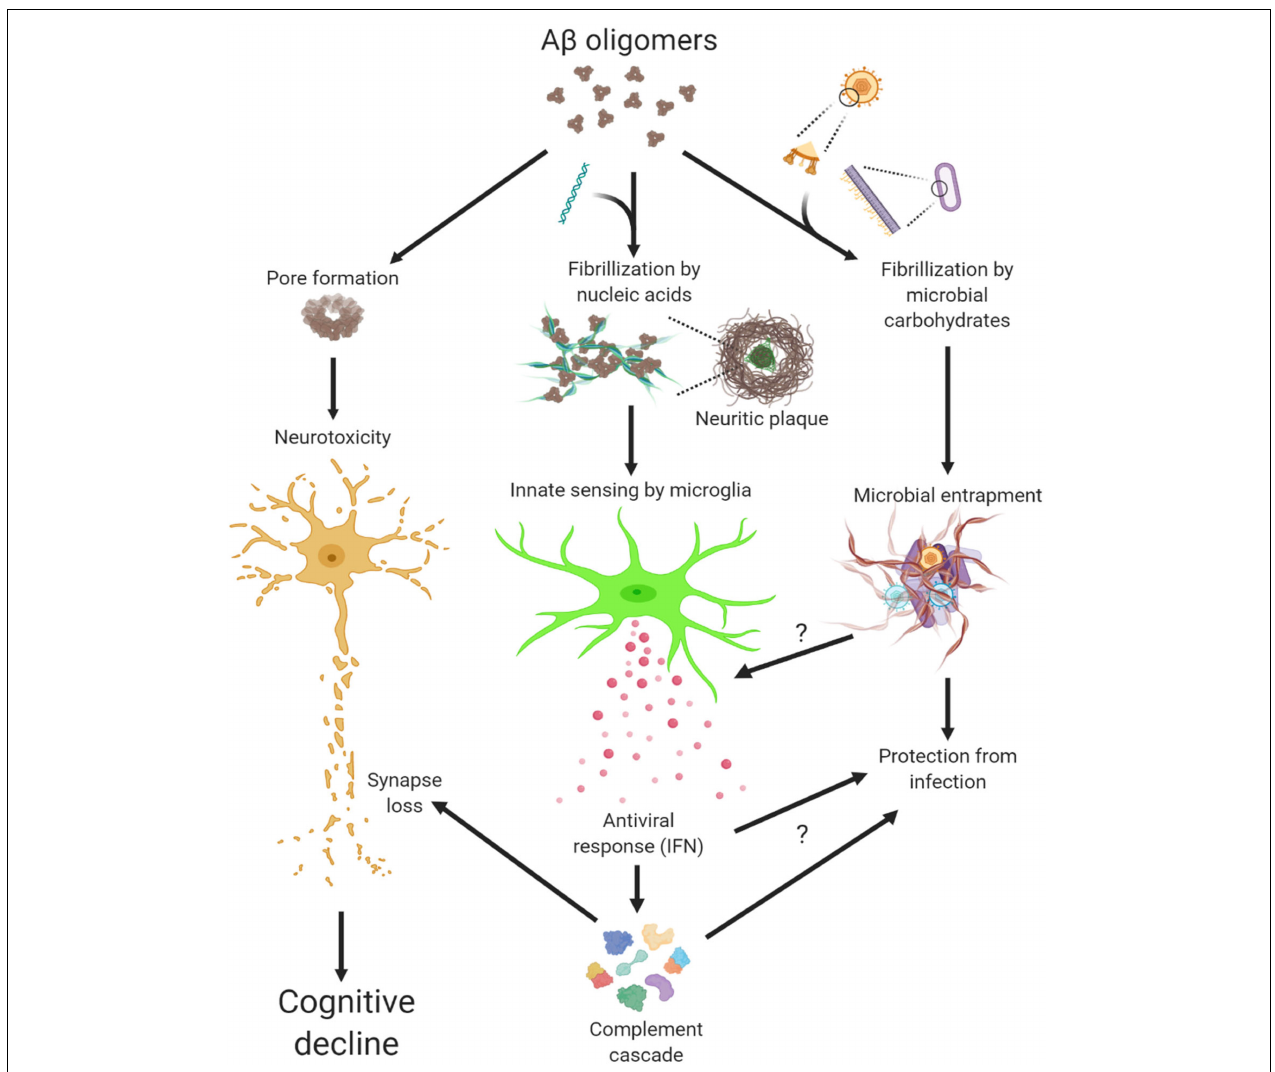
FIGURE 1 | Multiple actions of A β oligomers leading to neuropathogenesis in Alzheimer’s